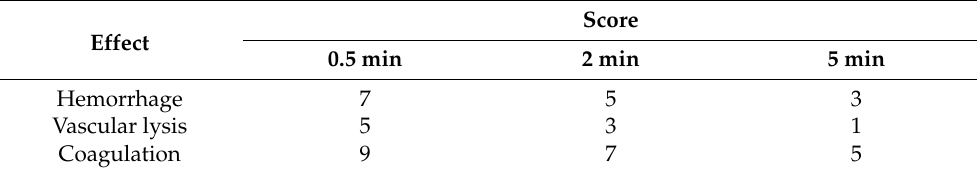
Table 1. Scoring scheme for irritation testing with the HET-CAM test